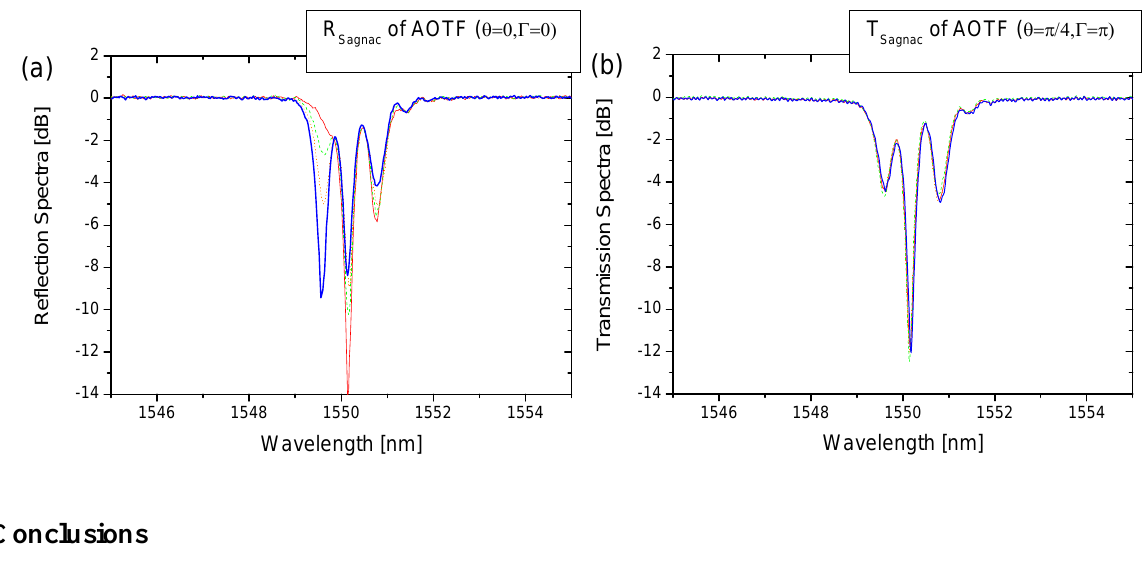
Figure 3. For various input polarization states, optical spectra of polarization-dependent acousto-optic LPFG sensor in a Sagnac loop are measured from (a) the reflection port of Sagnac loop (  = 0,  = 0) and (b) the transmission port of Sagnac loop (  =  4,  = 